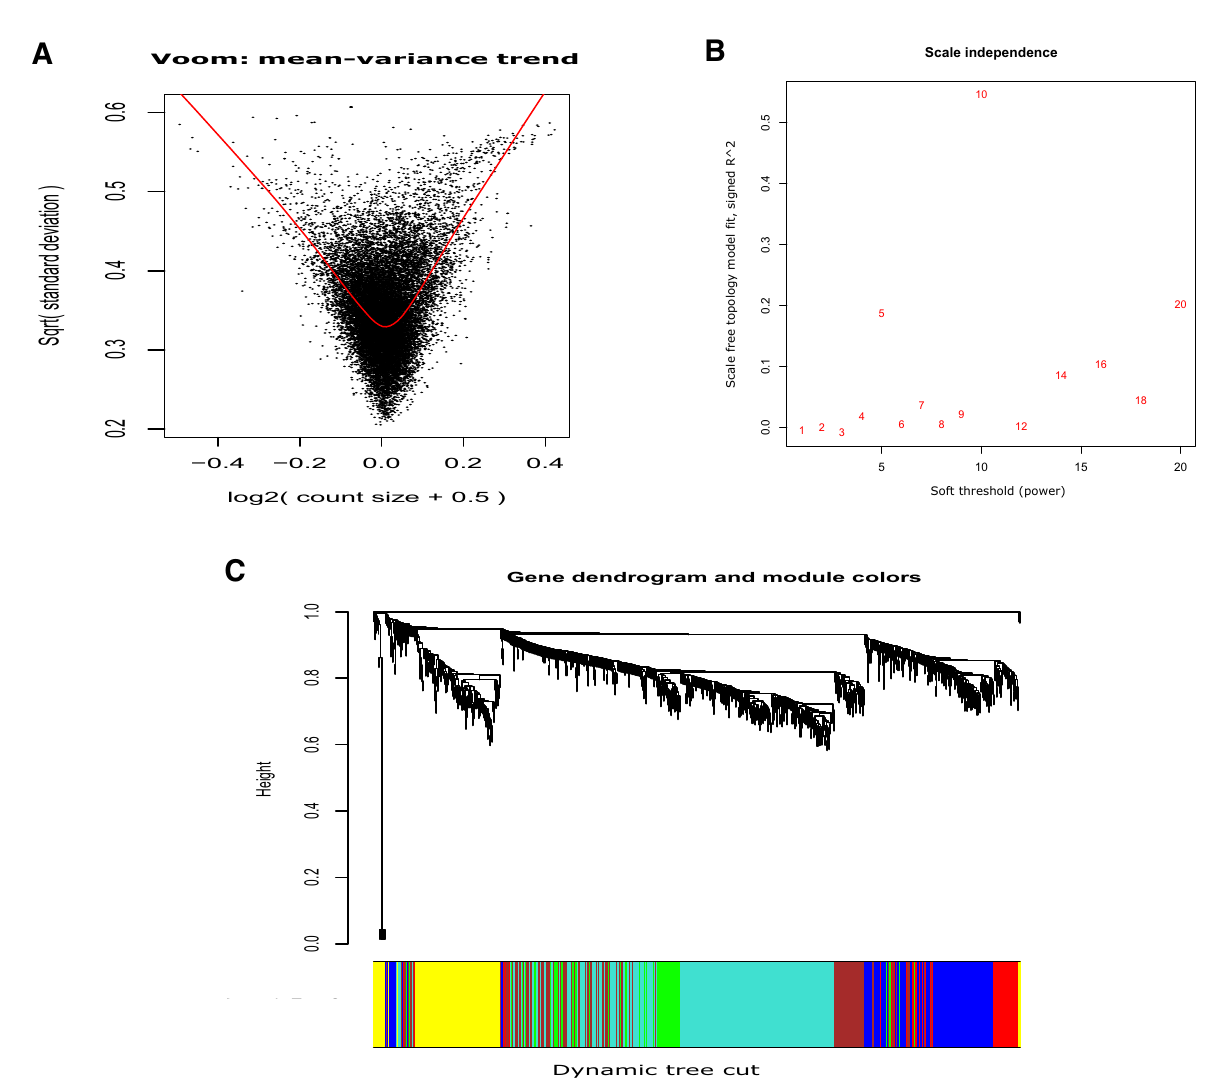
Figure 3. Plots for Voom normalization, power calculation for soft-thresholding and dendrogram for DS vs control. ( A ) Plot for Voom normalization for DS vs control. Voom normalization was used on the set of non- noisy features of the resultant clusters obtained from the pre-filtering analysis by DBSCAN clustering. ( B ) Power calculation for soft-thresholding in the comparison of DS vs control. This power computing is applied to ensure the scale free topology in the corresponding network. In this specific case, the final resultant power was set 10. ( C ) Dendrogram plot with color thresholding using dynamic tree cut method for the comparison of DS with control, while the x-axis denotes different gene modules represented by various colors and the y-axis shows the height of the tree (dendrogram).